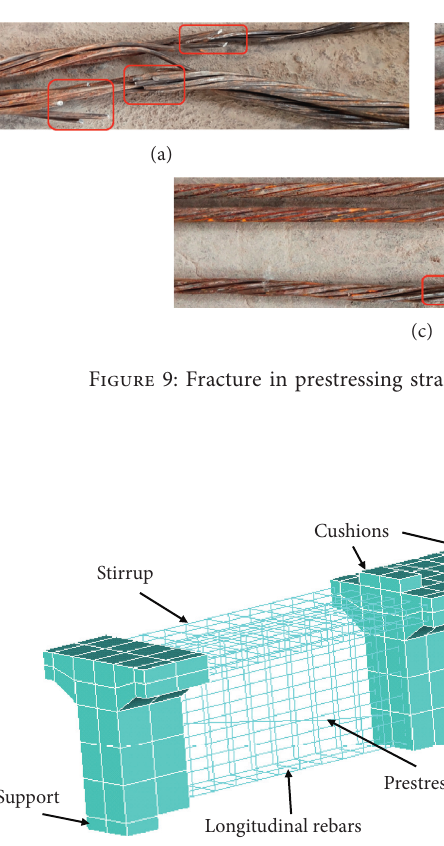
Figure 10: FE model of unbonded PC T bridge girders.